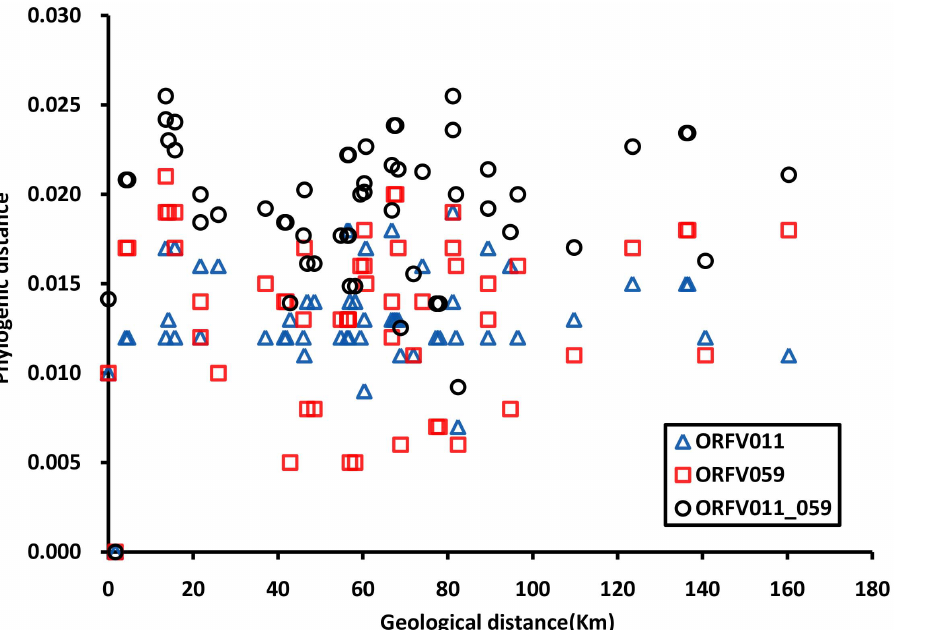
Figure 9. Ground-distance comparison based on ORFV011, ORFV059 and ORFV011-059 (with Euclidian distance). The y axis is the phylogenetic distance calculated by MEGA5, defined as substitutions per base. The x-axis is the distance in km between any pair of sample locations (as calculated by Google Maps). Three symbols represent phylogenetic distances based on ORFV011, ORFV059 and both sequences (ORFV011-059).